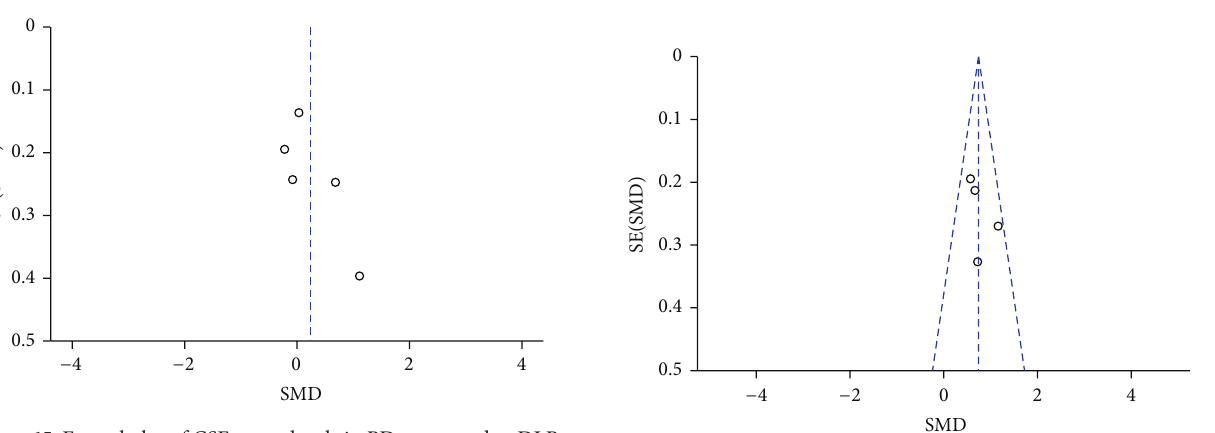
Figure 15: Funnel plot of CSF 𝛼 -syn levels in PD compared to DLB.